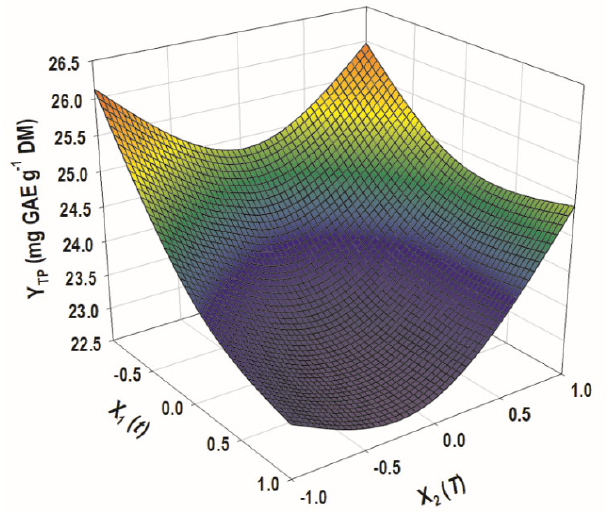
Figure 4. The three ‐ dimensional diagram illustrating the effect of process (independent) variables Figure 4. The three-dimensional diagram illustrating the effect of process (independent) variables on on the response (Y TP ). the response (Y TP